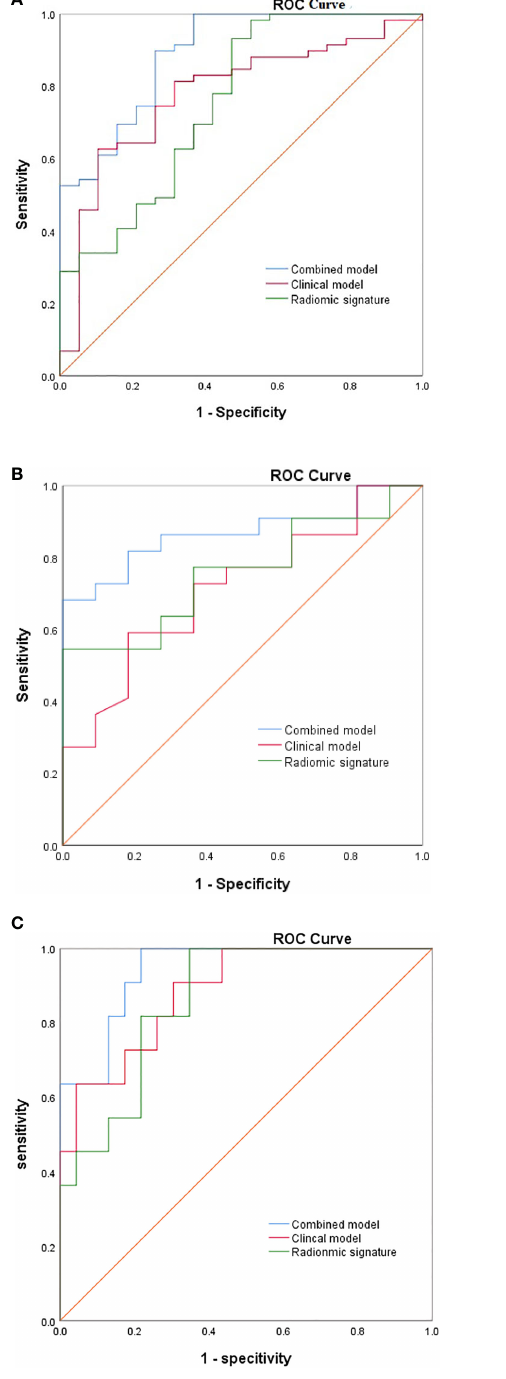
FIGURE 4 The ROC of the three model from (A) the training cohorts, (B) the internal validation cohort, (C) the external validation